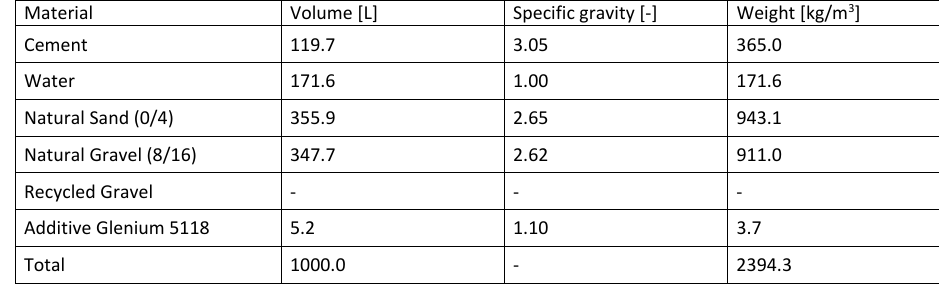
Table 2. Mix composition for benchmark concrete (0% coarse aggregate replacement)